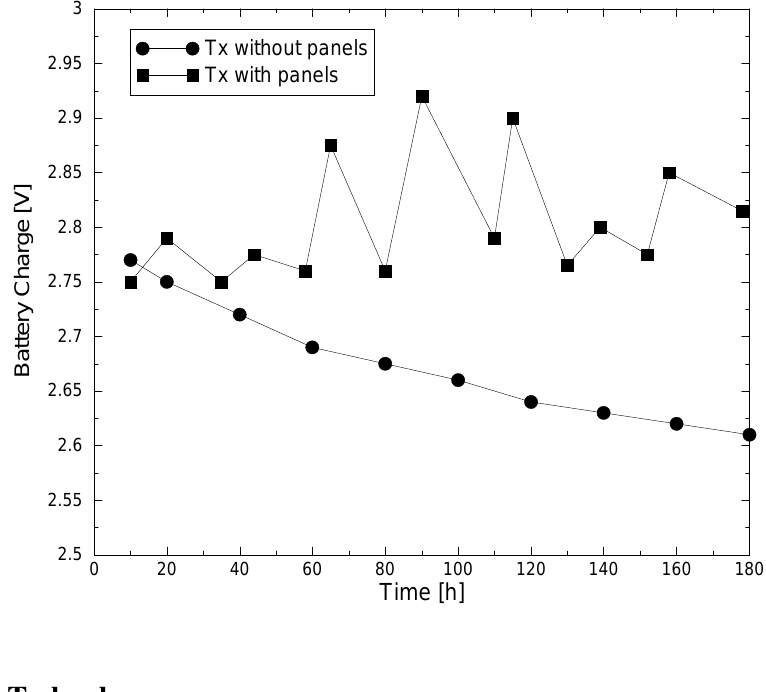
Figure 4. The behavior of the battery charge in Volt by passing time, expressed in hours, when photovoltaic panels are used and